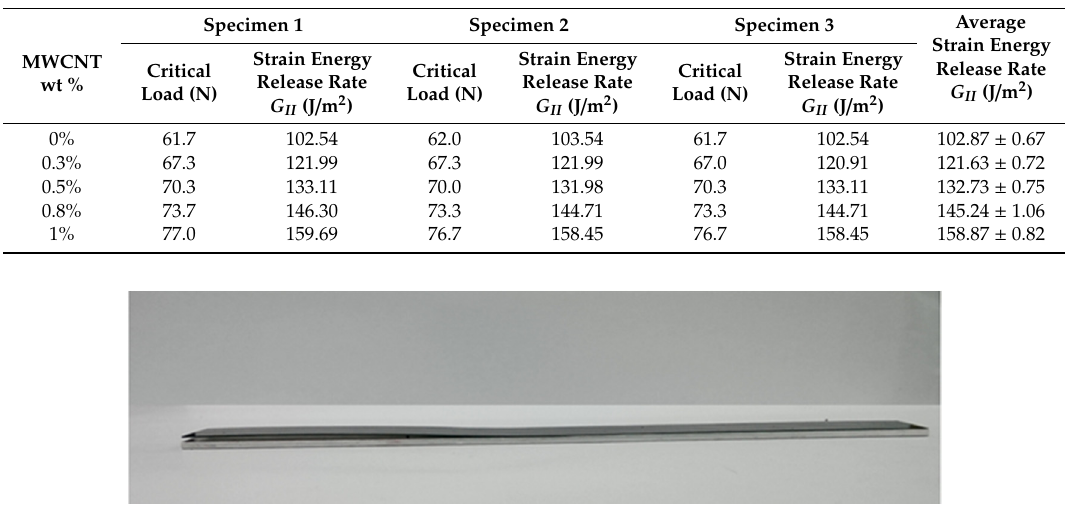
Figure 8. ENF specimen.